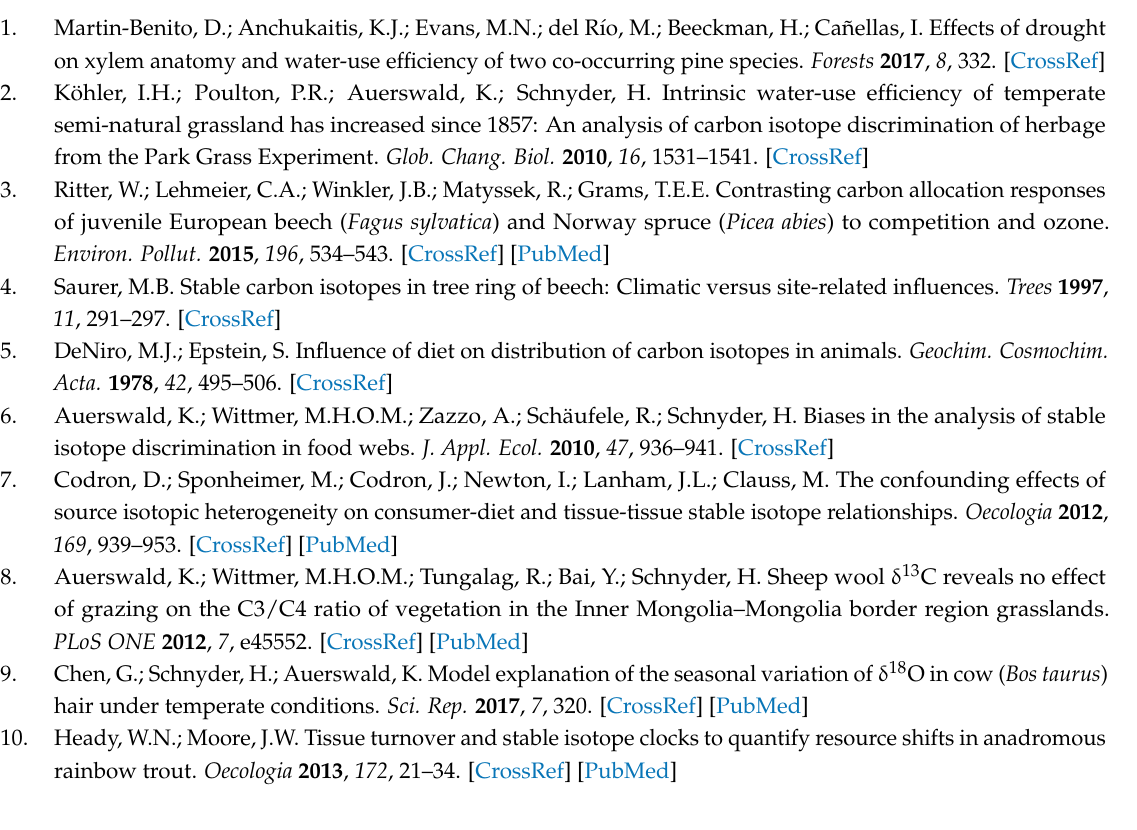
Figure S1: Relation between the seasonal variation of δ 13 C and the mean δ 13 C and δ 15 N in hoof keratin, Figure S2: Comparison of δ 13 C of the rumen content and δ 13 C of the youngest millimeter of the hoof wall close to the periople, Table S1: Statistical parameters of isotope ratios in hooves of 17 analyzed roe deer. The data analyzed in this study are archived at ResearchGate